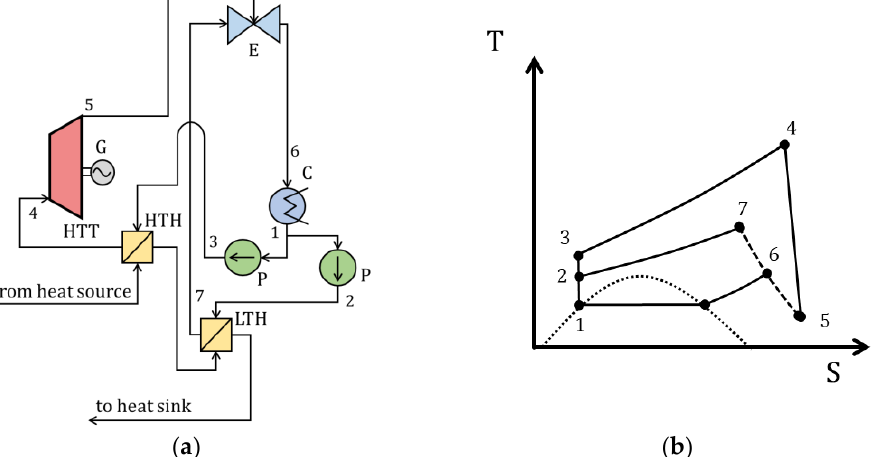
Figure 14. Supercritical CO 2 Rankine with an ejector: ( a ) schematic diagram; ( b ) T – S diagram [23]. HTT — high-temperature turbine; HTH — high-temperature heater; LTH — low-temperature heater; P — pump; C — condenser; E — ejector; G — generator.